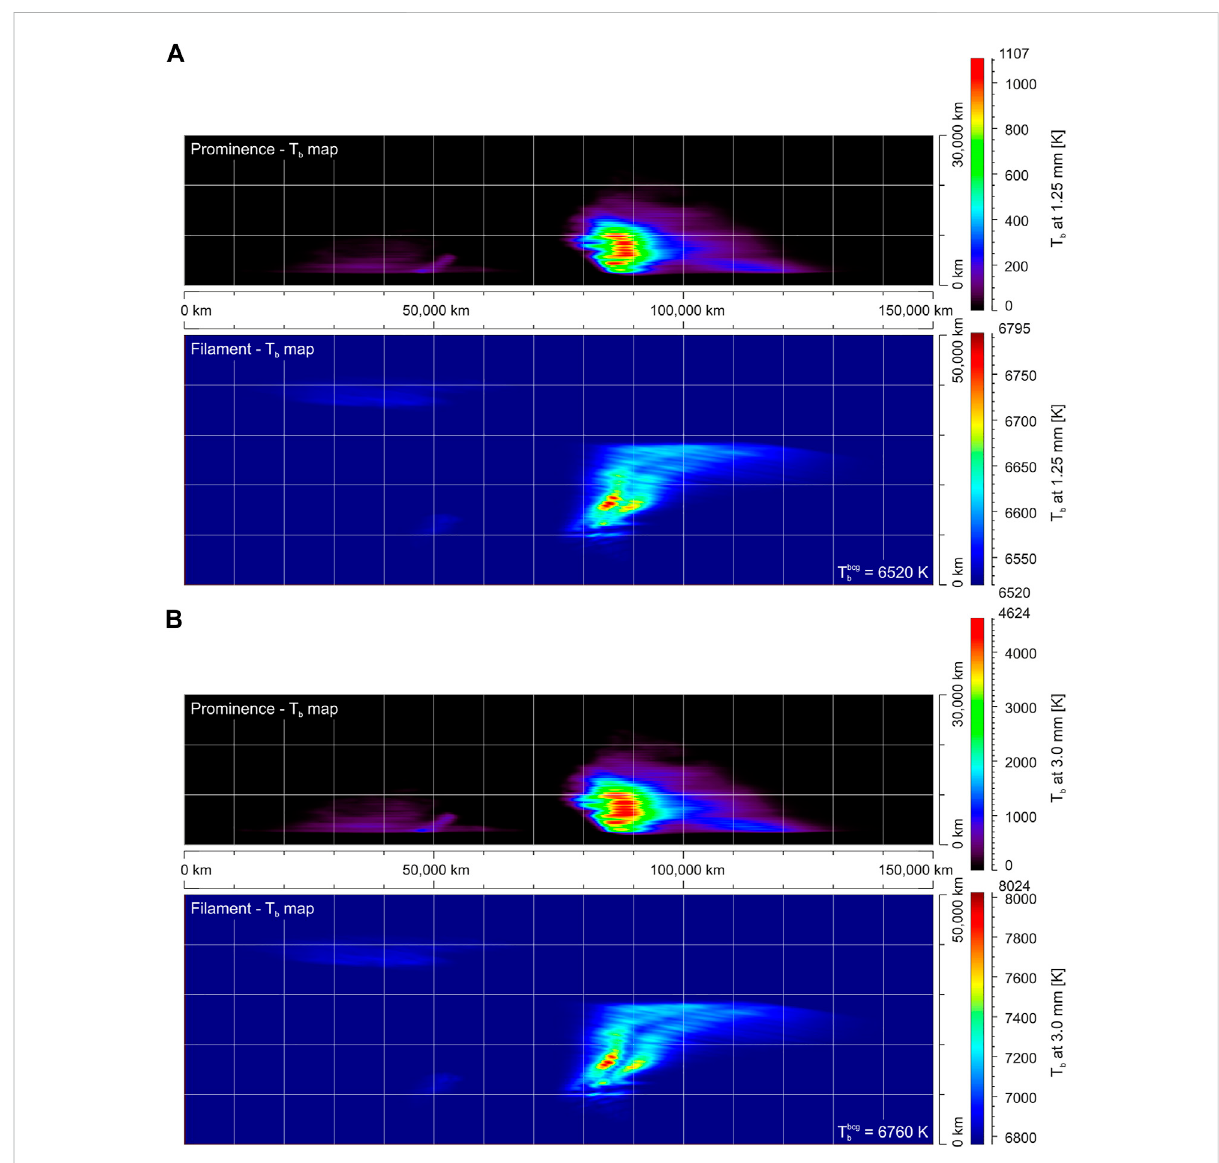
FIGURE 2 Visualizationofthe3DWPFSmodel. (A) :synthetic imagesobtained inBand6at1.25 mmwavelength (240 GHz). (B) :syntheticimages obtained in Band 3 at 3.0 mm wavelength (100 GHz). Each pair of panels shows the brightness temperature map for the prominence view (top) and the brightnesstemperaturemapforthe fi lamentview(bottom).Displayedcolorscalesareuniqueforeachpanel.Thevalueofthebackgroundbrightness temperature T bcg b is indicated in the panels showing the fi lament view. Adapted from Gunár et al.